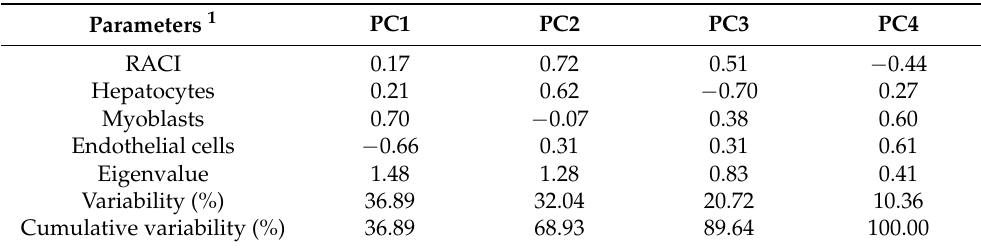
Table 4. Principal component analysis (PCA) of the antioxidant and cytoprotective capacities of whole wheat extracts (WWE); eigenvalues and percentage variability explained by the first four components.